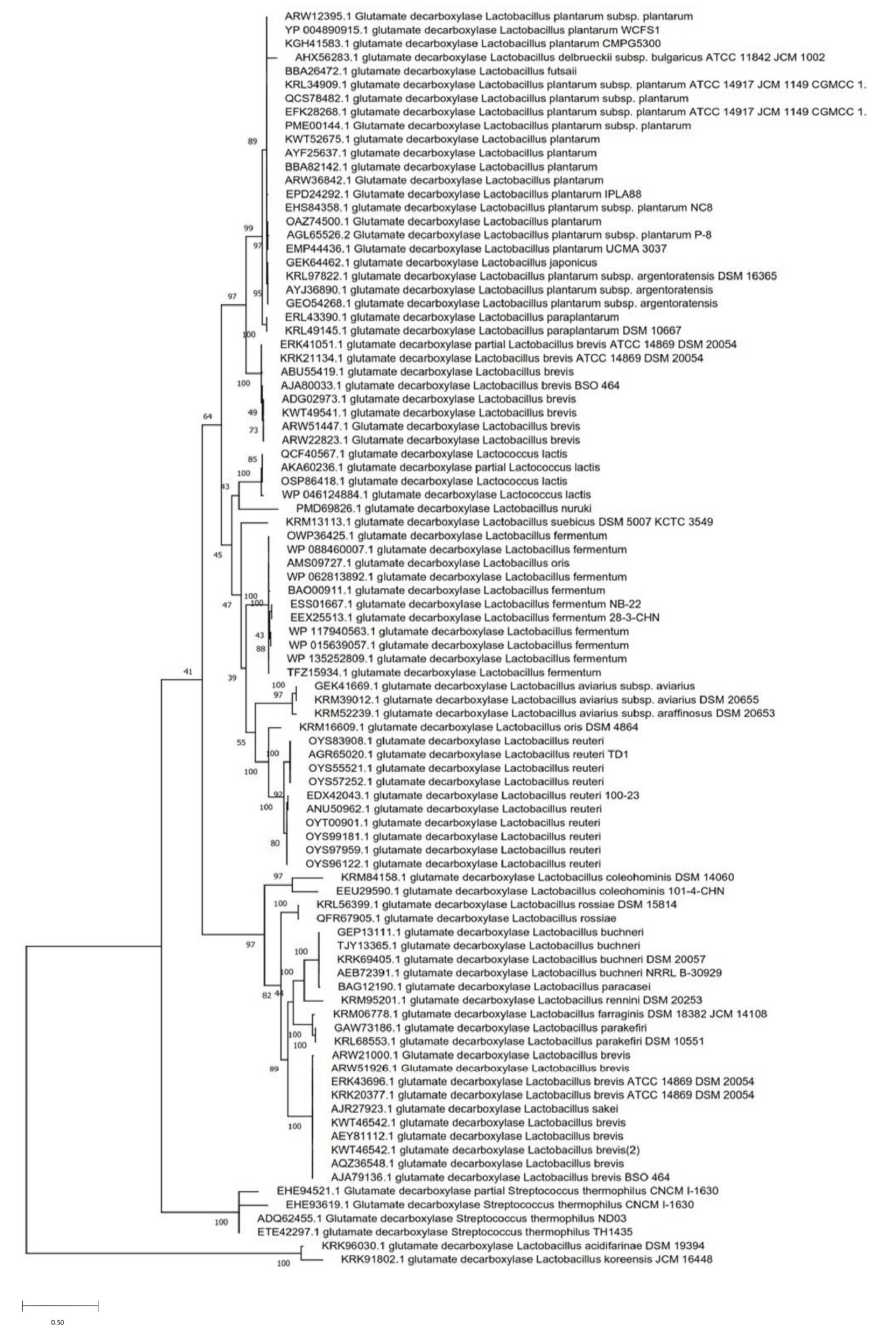
Figure 3. Phylogenetic analysis of glutamate decarboxylase from different species of LAB. The phylogenetic tree was calculated based on the amino acid sequences of glutamic acid decarboxylase (GAD) (maximum-likelihood method). The phylogenetic analysis was performed after the alignment of GAD sequences using MUSCLE in the MEGA X